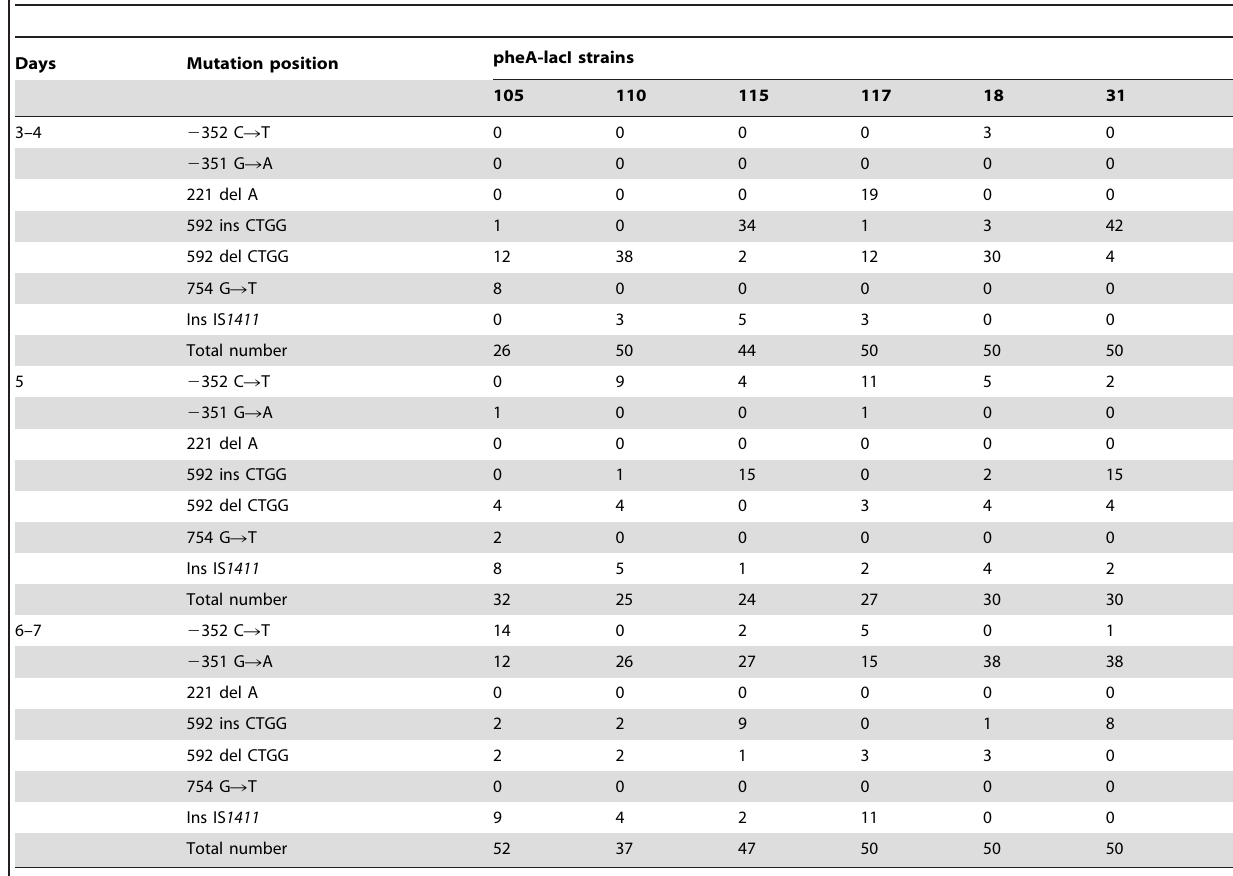
Table 5. Time-dependent appearance of mutational hot spots in P. putida strains carrying the phe-lacI test system.